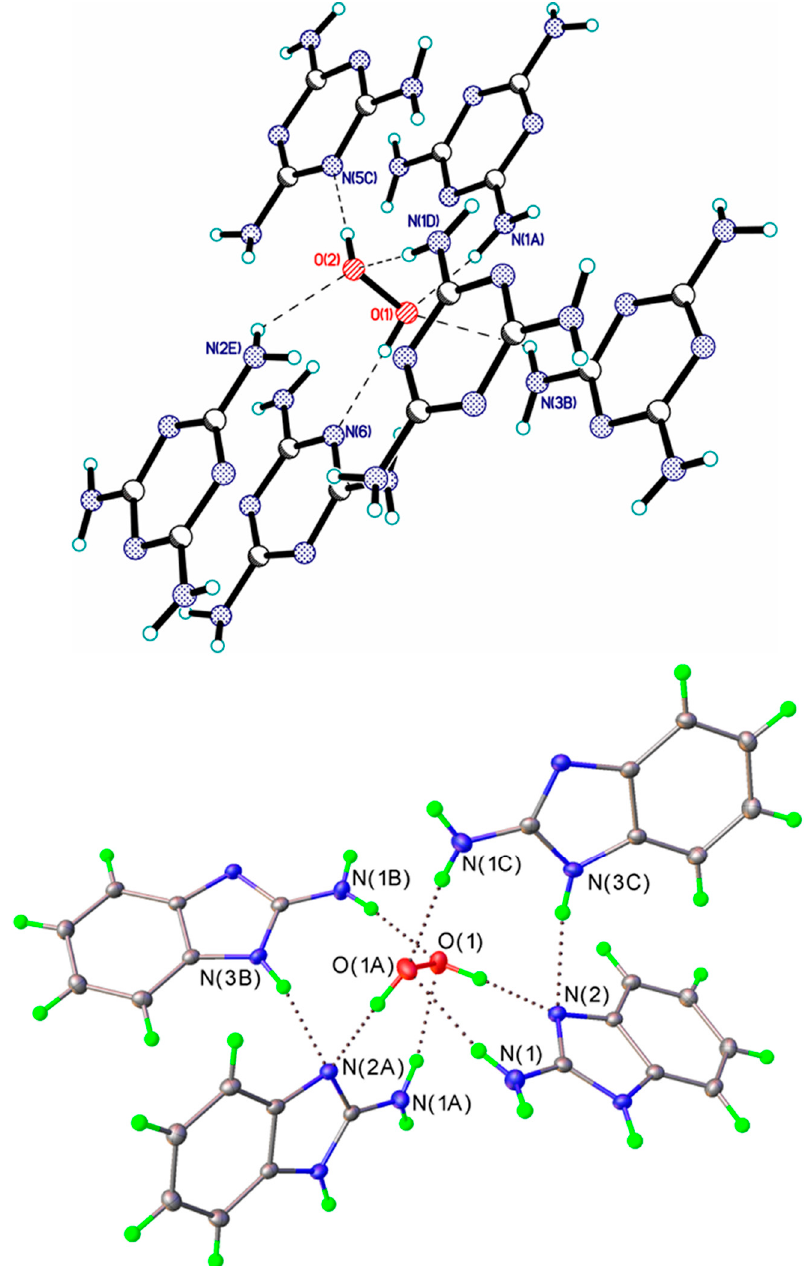
Figure 5. Crystals with the maximum number of H-bonds. H-bonds are denoted by dotted lines. Top panel: melamine peroxosolvate. Adapted with permission from the authors of [25]. Copyright 2017 American Chemical Society. Bottom panel—2-aminobenzimidazole peroxosolvate. Reproduced from the work in [26] with permission from The Royal Society of Chemistry.